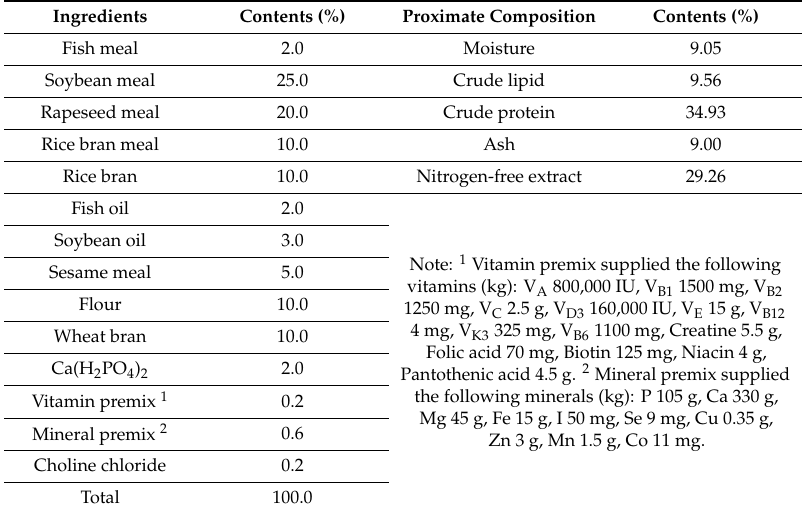
Table 1. Formulation and proximate composition of the